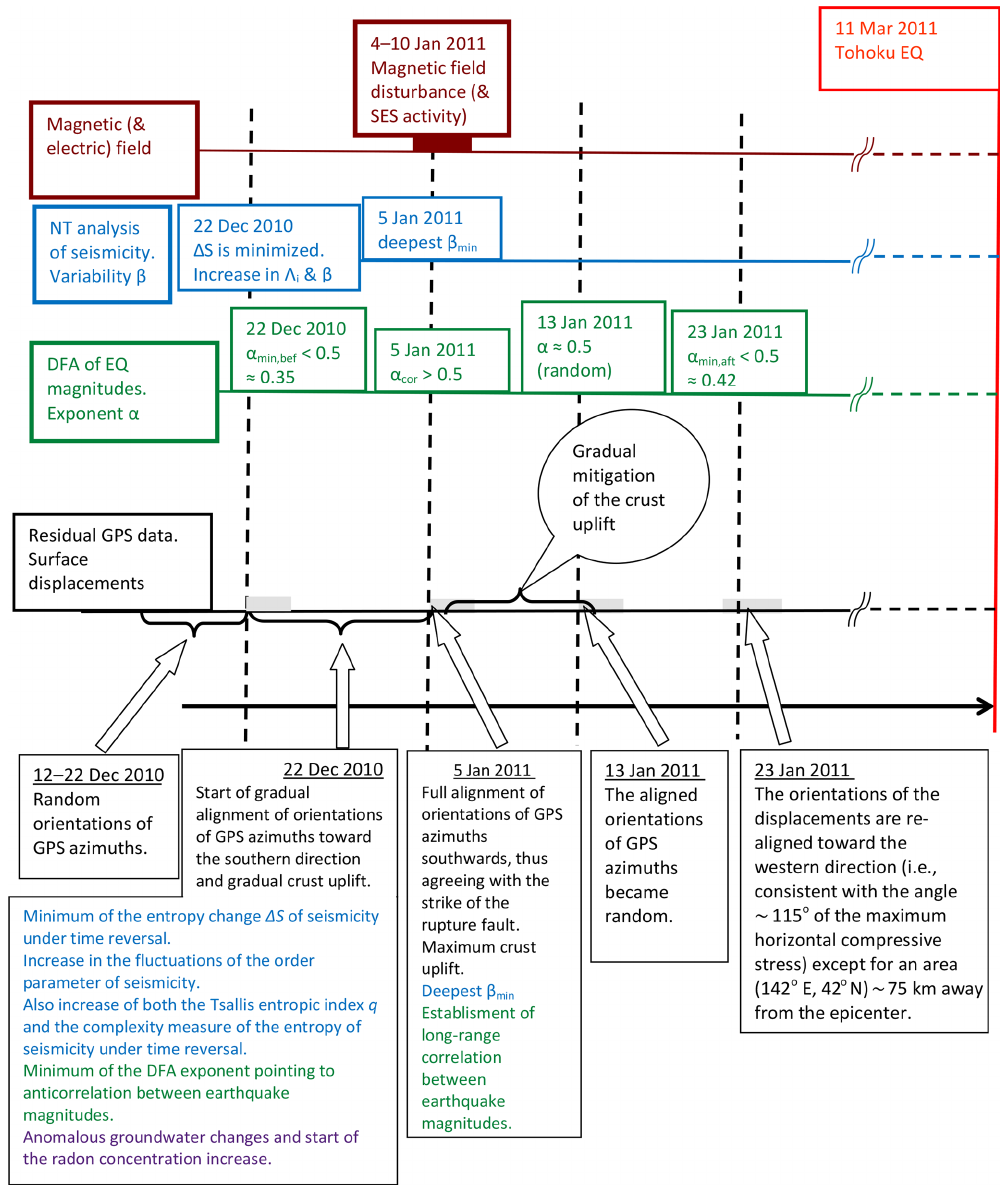
Figure 3. Schematic diagram that compiles the multidisciplinary changes before the T ¯ ohoku EQ. Period of observations: from 12 Decem- ber 2010 until 23 January 2011. The black text describes the observations by means of residual GPS data, the brown text describes those obtained by means of Earth’s magnetic field variations, the green text describes those obtained by detrended fluctuation analysis (DFA), the blue text describes those obtained by natural time analysis, and the purple text describes those obtained by anomalous groundwater and radon